Question: Express in one sentence what the figure is showing.
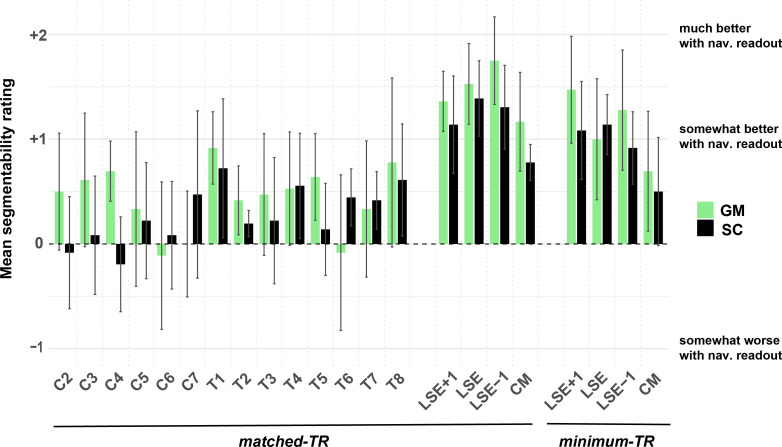
Answer: Qualitative comparison. Segmentability ratings of the spinal cord (SC, black) and gray matter (GM, light green) on multi-echo gradient-echo acquisitions with optimized navigator processing versus without navigators, across cervical (C2-C7) and thoracic (T1-T8) vertebral levels, as well as at lumbosacral landmarks: the lumbosacral enlargement (LSE), two slices rostral (LSE+1) and two slices caudal (LSE-1), and the conus medullaris (CM). Values were averaged across participants and raters, and the standard deviation was calculated across raters. Positive values indicate preference for the image with navigators, while negative values indicate preference for the image without. Ratings reflect the degree of preference: the image with navigators is much better (+2), somewhat better (+1), no difference (0), somewhat worse (–1), or much worse (–2).